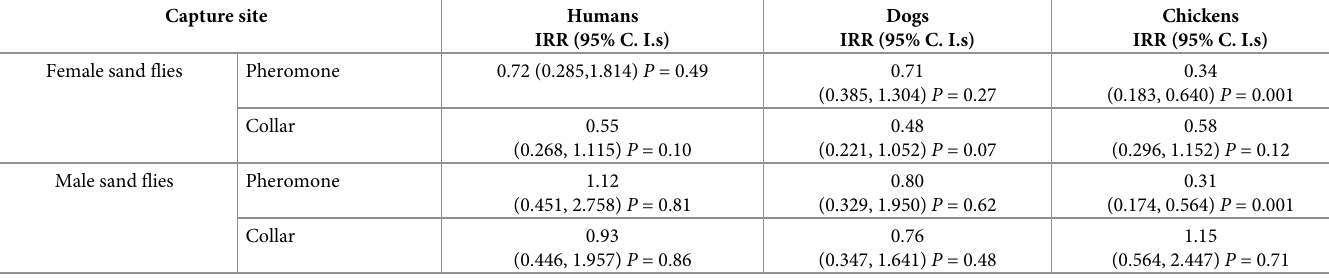
Table 7. Intervention effects on Lu . longipalpis abundance at host-associated CDC trap sites. Capture